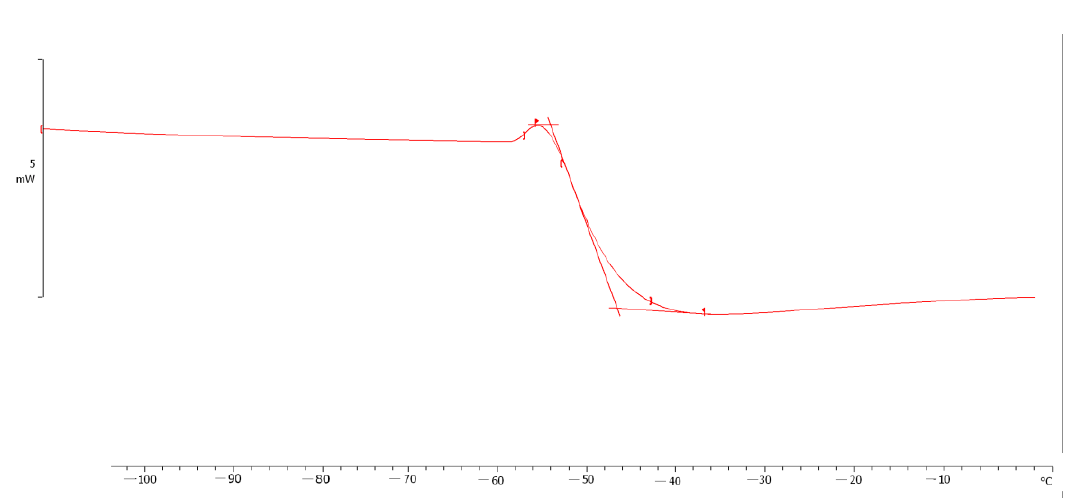
Table 2. Glass transition temperatures of PVC compositions containing alkyl butoxyethyl adipates.